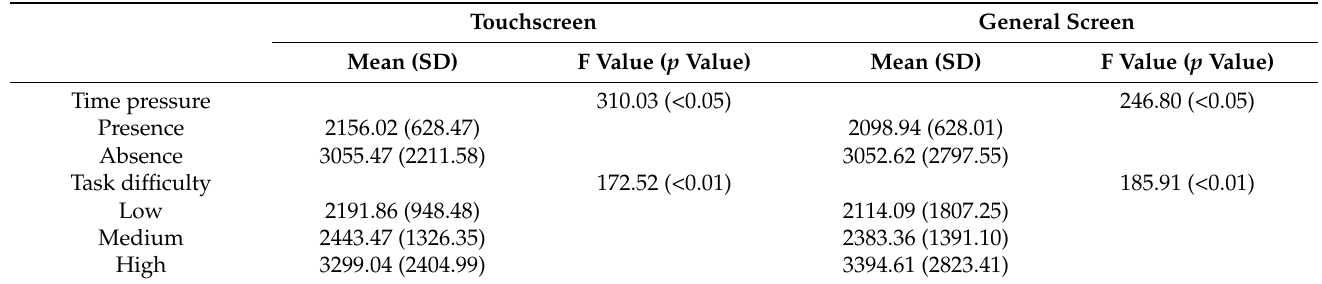
Table 1. Completion time (milliseconds (ms)) statistics under different time pressures and task